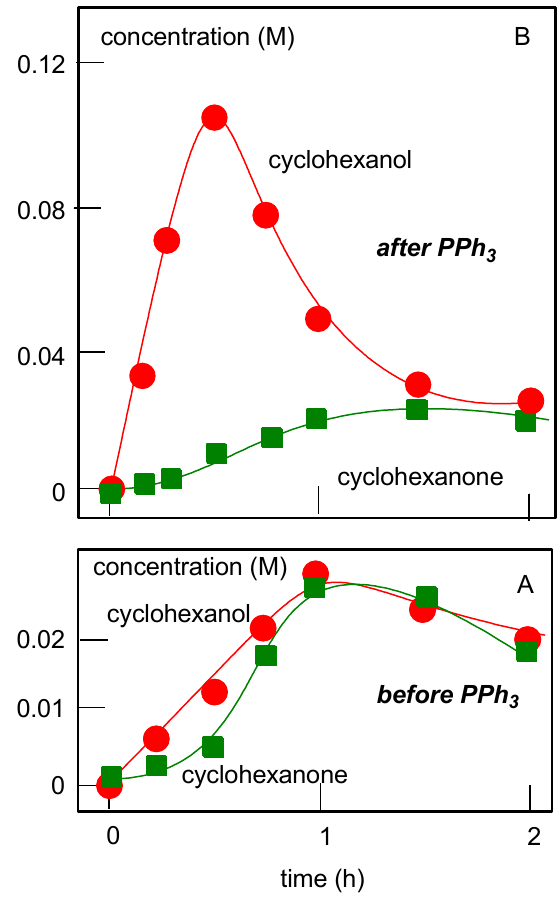
Figure 13. Oxidation of cyclohexane with H 2 O 2 (50%) catalyzed by complex 18 at 60 °C. Concentrations of cyclohexanol and cyclohexanone were measured both before ( A ) and after reduction ( B ) with PPh 3 (used method of Shul’pin). Adapted from [81], Copyright (2018) with permission of Wiley.